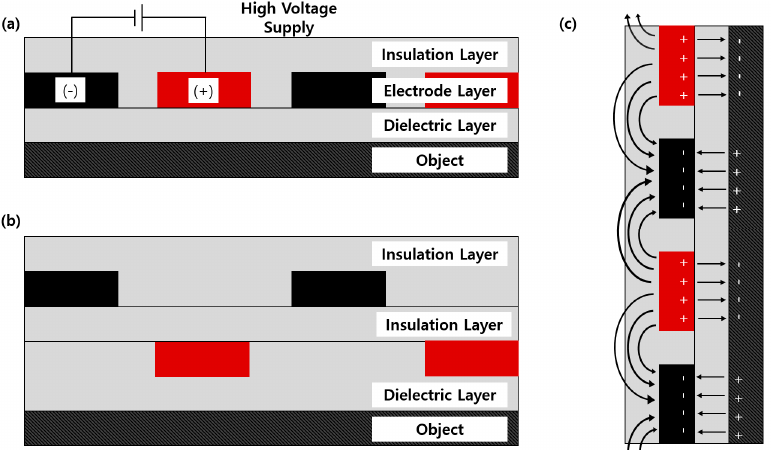
Figure 1. Structure of the electroadhesion pad: ( a ) one insulation layer type; ( b ) dual-insulation layer type; ( c ) charge formation on the electroadhesion pad.